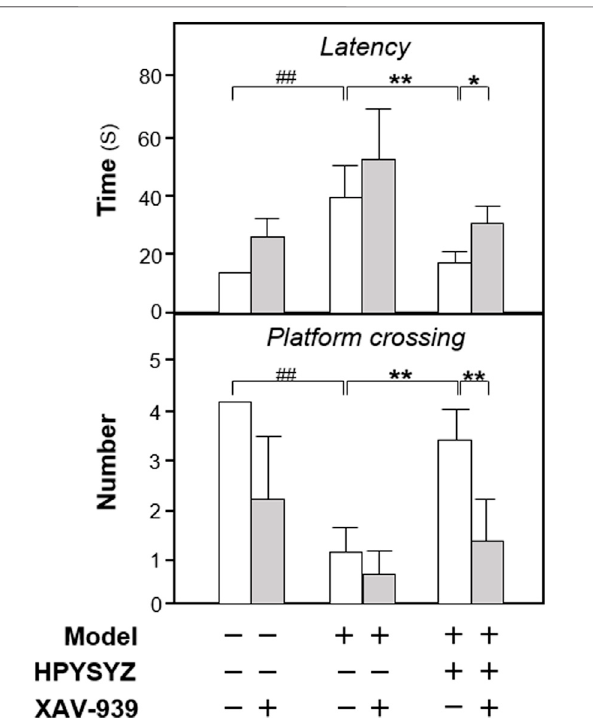
FIGURE6| Effectofco-treatmentofXAV-939andethylacetateextracts ofsuccinumonlearningandmemoryabilitiesofcarotidarteryligationrats.The effect of co-treatment of XAV-939 and ethyl acetate extracts of succinum on learning and memory abilities on carotid artery ligation rats were evaluated by determining the latency time and platform crossing number of water maze test. Values are expressed as mean ± SEM ( n = 8). Comparisons between groups were carried out by a one-way ANOVA followed by a post hoc Bonferroni test. ## p < 0.01, * p < 0.05, and ** p <